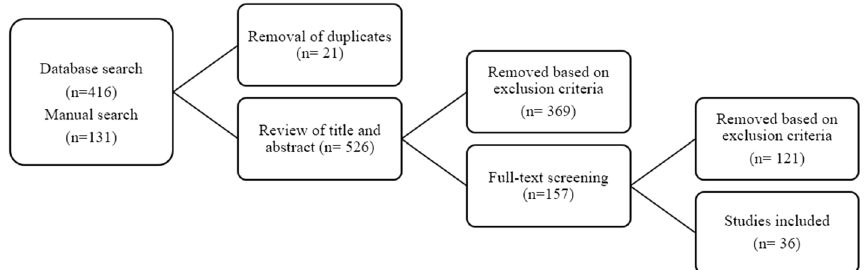
Fig. 1 Article screening with the PRISMA